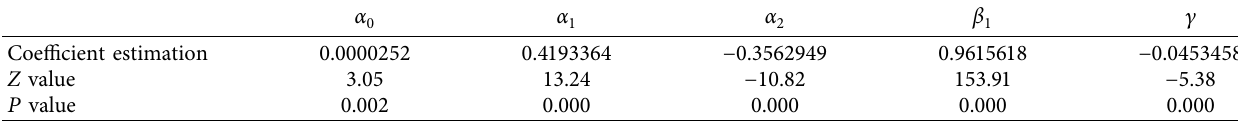
Table 7: Estimation of GJR-GARCH (2, 1) model.